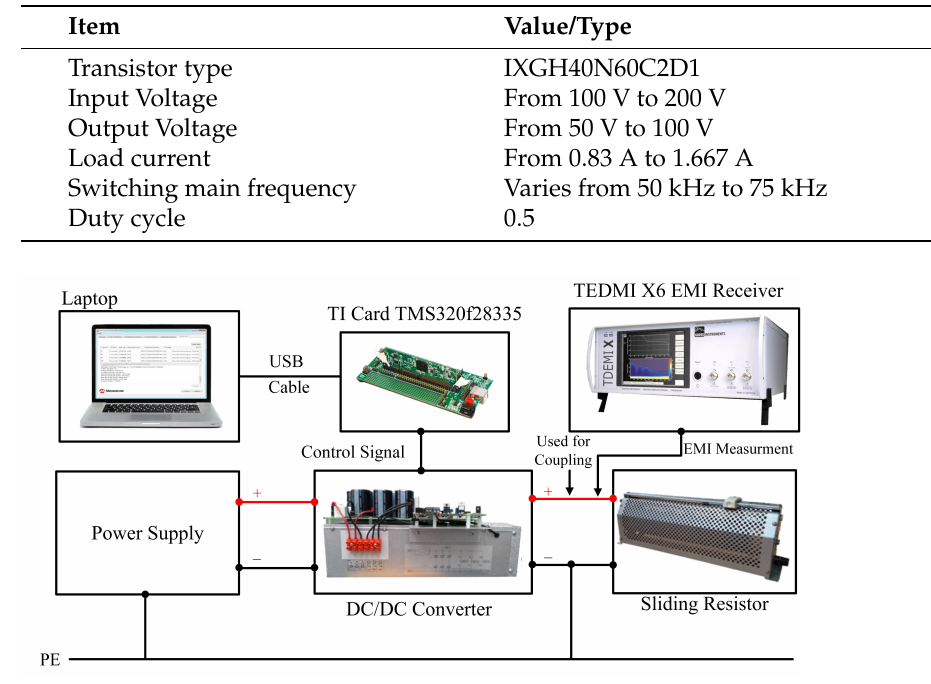
Figure 4. Connection diagram of the DC/DC converter control.